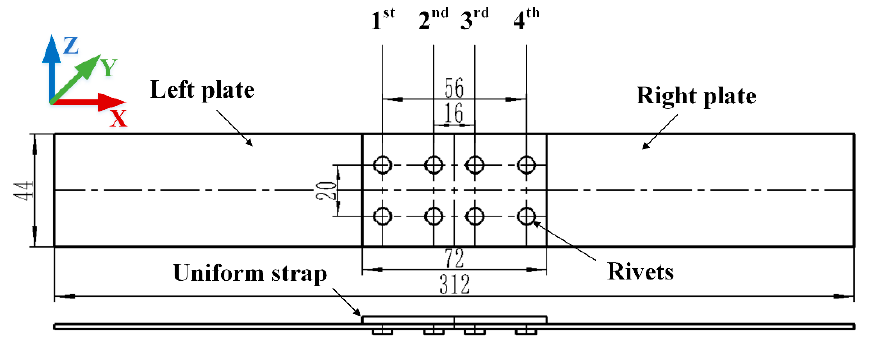
Figure 6. Schematic diagram of riveted single strap butt joint. The strap thickness and the sizes of riveting in four columns are two variable parameters.